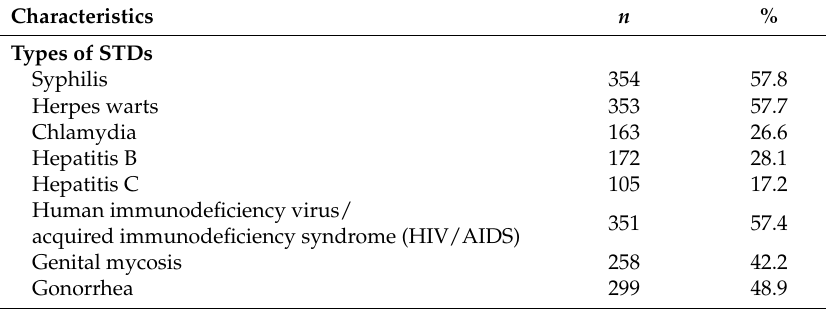
Table 2. Knowledge of participants towards